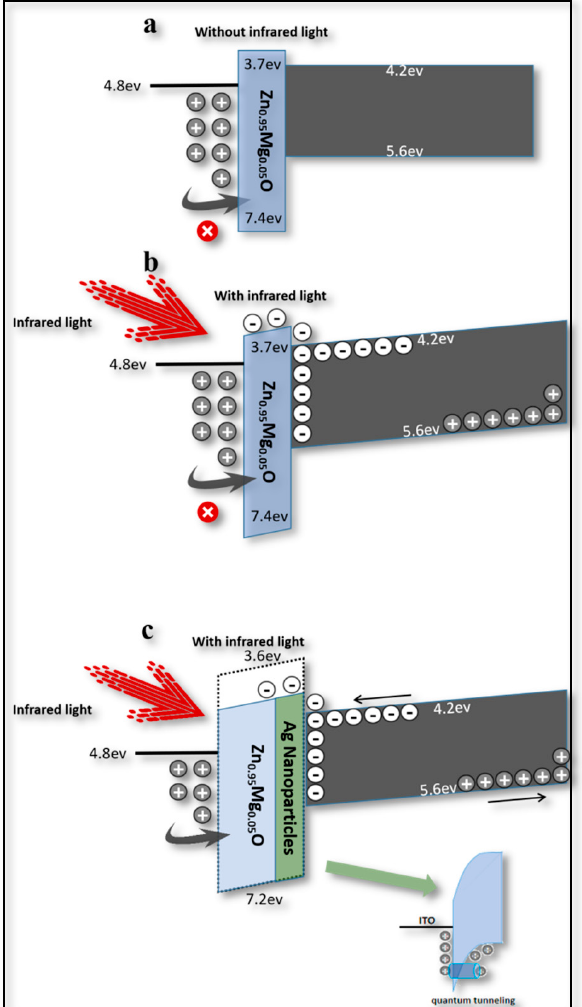
Figure 4. Potential barrier mechanism diagram of Zn 0.95 Mg 0.05 O and PbS interface. ( a ) Without Ag NPs and NIR light. ( b ) Without Ag NPs and with NIR light. ( c ) With Ag NPs and NIR light.